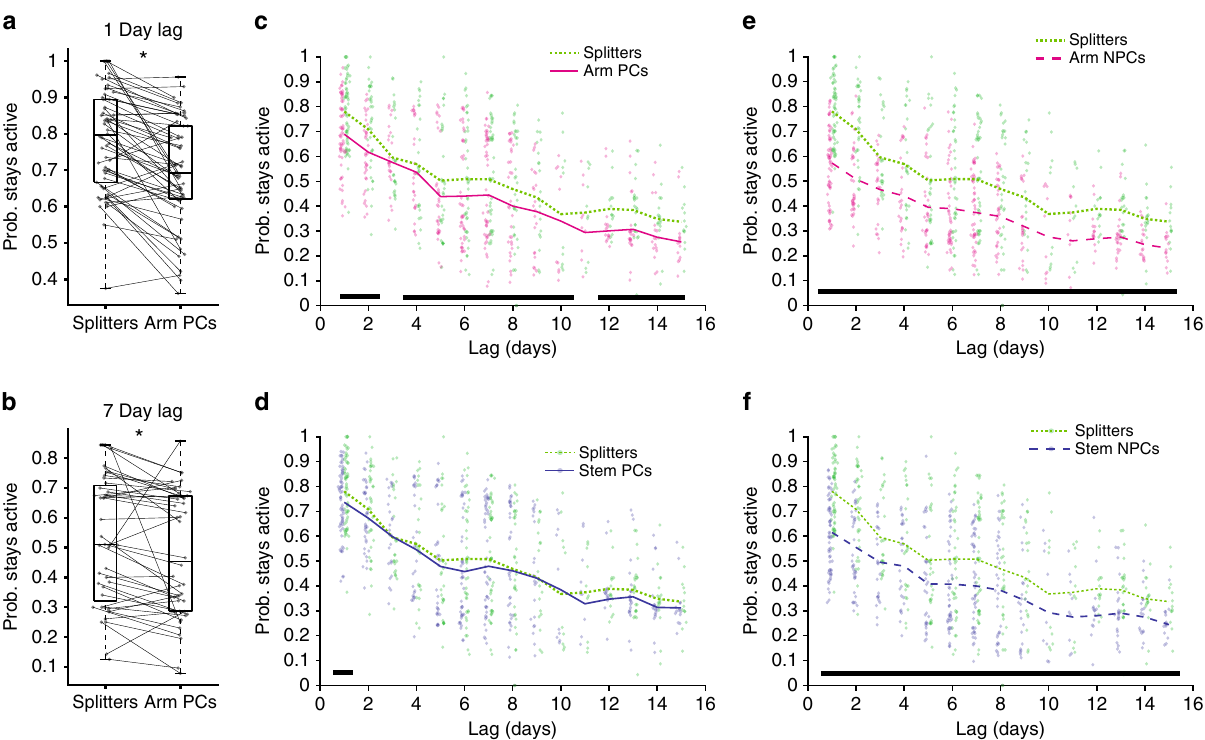
Fig. 4 Splitter neurons are more likely to remain active between sessions than other neurons. a Probability that splitters and arm place cells (PCs) stay active one day later for all mice. * p = 6.7 × 10 − 8 , n = 58 session pairs, one-sided signed-rank test. Box plots show median and 1st/3rd quartiles, whiskers extend to 1.5× interquartile range. b Same as a, but for sessions 7 days apart. * p = 4.1 × 10 − 4 , n = 44 session pairs, one-sided signed-rank test. c Probability splitters and arm place cells stay active versus lag between sessions. Dots = probabilities from individual session pairs, lines = mean probability at each time lag. Green dashed = splitters, Magenta = arm PCs. Black bars = signi fi cant differences after Holm-Bonferroni correction (15 day lags considered) of one-sided signed-rank test. See Table 1 for signed-rank test p -values at all lags, α = 0.05. d Same as c but for comparison to stem PCs (blue). e , f Same as ( c , d ) but for comparison to arm and stem non-place cells (long